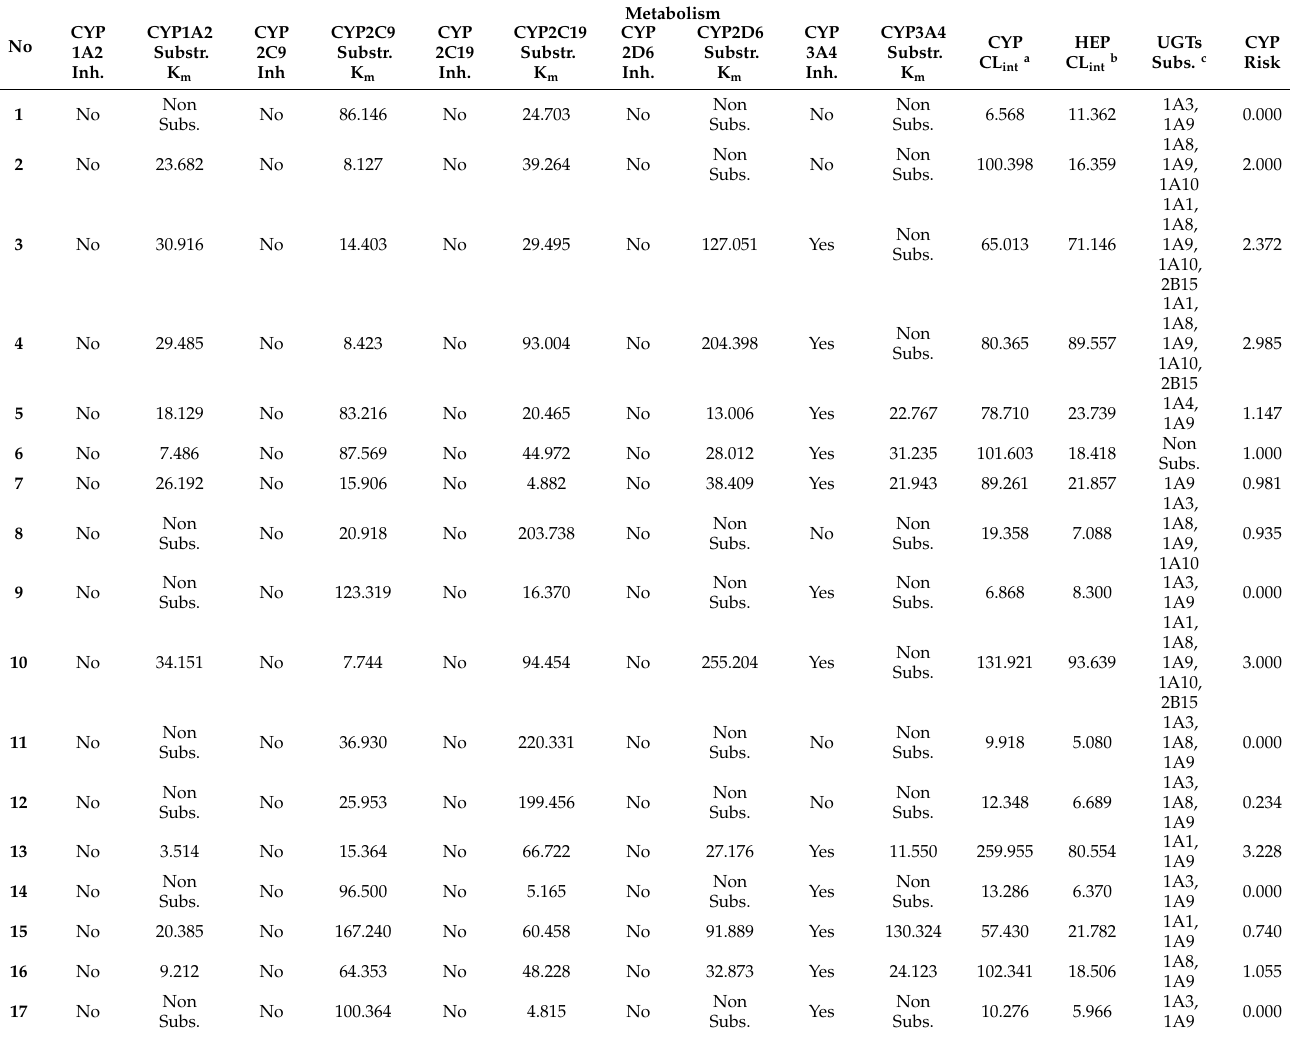
Table 8. Studies on the metabolism characteristics of compounds 1 – 17